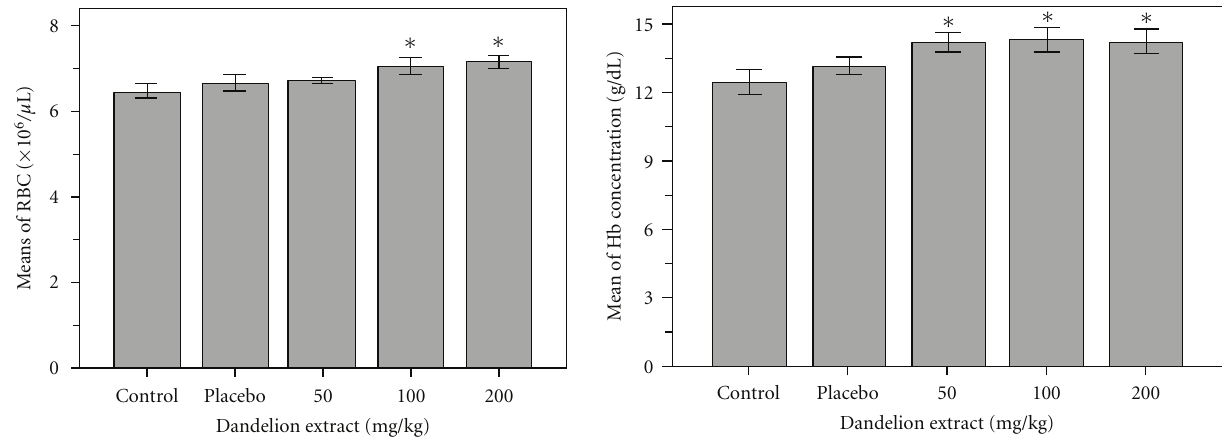
Figure 1: Comparison of average number of red blood cells and mean hemoglobin concentrations between experimental groups, control and placebo.